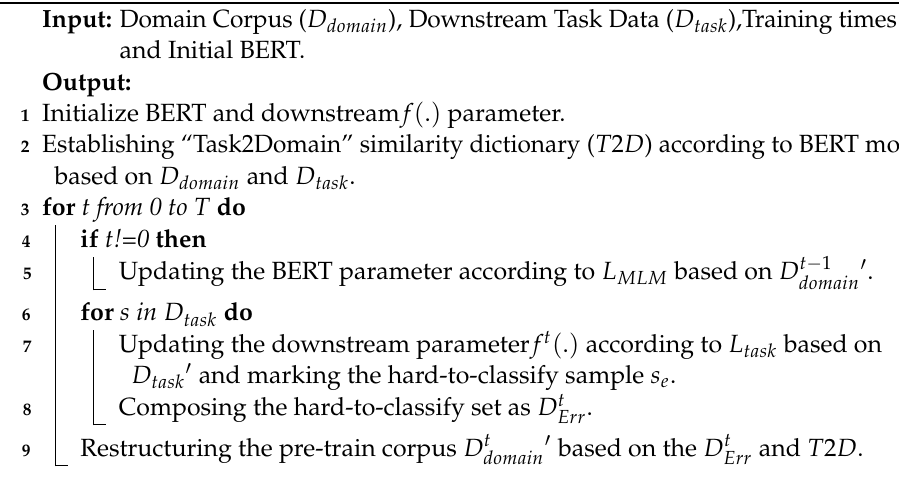
Algorithm 1: The Joint Pre-training Procedure